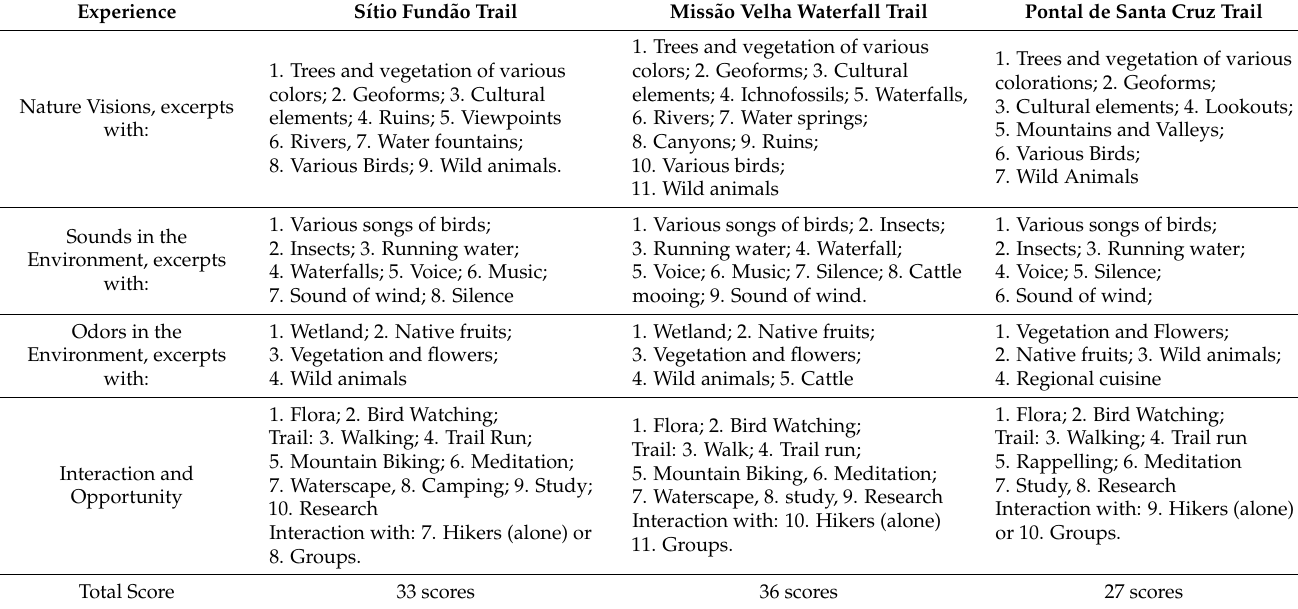
Table 3. Wellness Experiences and Health Opportunities; S í tio Fund ã o, Miss ã o Velha Waterfall; Pontal de Santa Cruz trails; Araripe